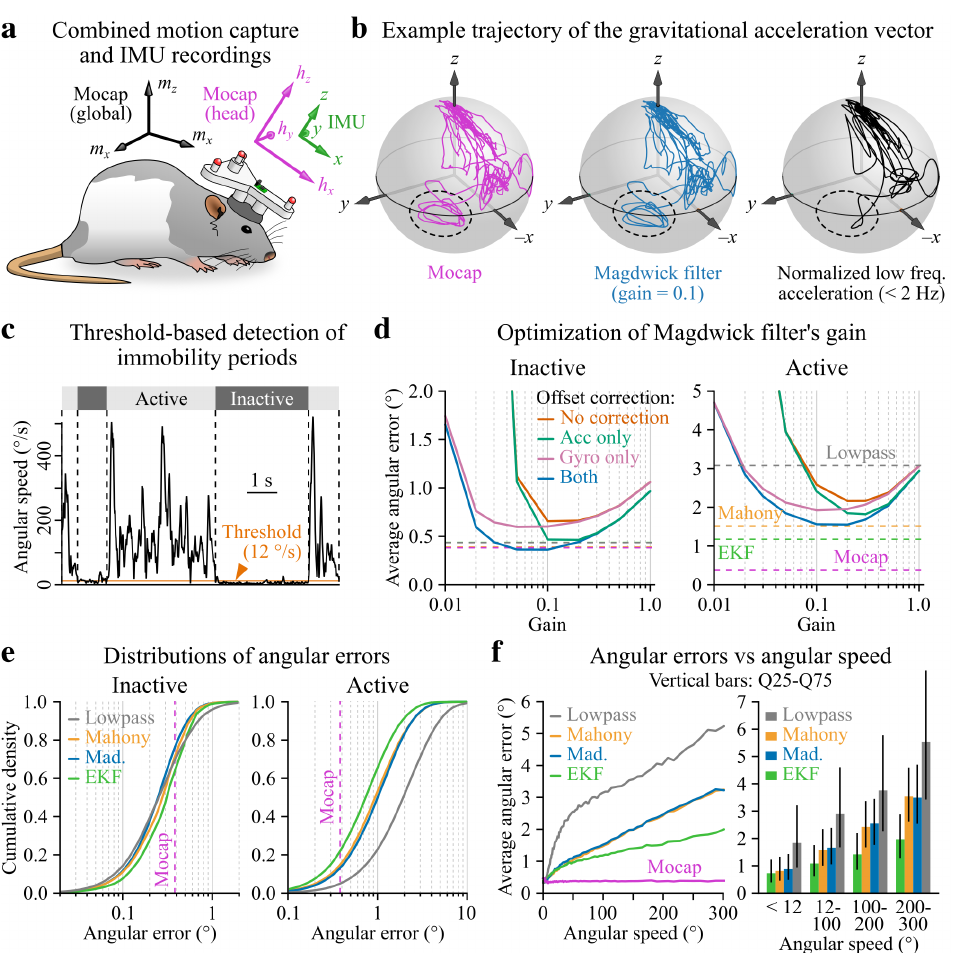
Figure 2. Calculation of the accuracy of IMU-based head tilt estimation using concurrent 3D optical motion capture in freely moving rats. ( a ) Animals were equipped with a head-mounted 3D-printed support containing four IR reflectors for motion capture (here shown in red) and a wired IMU (wire not represented). ( b ) Example trajectories of the actual gravitational acceleration vector (motion capture, left), of its estimate calculated with the Madgwick filter (middle) and of the normalized low frequency acceleration ( < 2Hz, right) over a period of 45s. The dashed ellipse highlights the region visited during a belly grooming episode. ( c ) Example angular speed trace (i.e., norm of the angular velocity vector) and corresponding periods of movement and immobility detected using a threshold of 12°s − 1 (orange line; see Section 2.9). ( d ) Average tilt estimation error for the Madgwick filter plotted against the filter’s gain, during immobility (inactive, left) vs. movement (active, right) and with or without offset correction. Dashed lines represent the average error calculated with the best set of parameters for other filters as well as the uncertainty in motion capture data (see Section 2.6.3). ( e ) Cumulative distribution of tilt estimation errors for all IMU filters during immobility (inactive, left) vs. movement (active, right). The vertical purple dashed line represents the uncertainty in optical motion capture data. ( f ) Tilt estimation error plotted as a function of the angular speed (left) and median error values and interquartile intervals calculated by bins of angular speed (right). Motion capture error was also plotted to confirm that the uncertainty in the optical estimation of tilt did not increase for specific ranges of angular speed (e.g., due to high intensity movements such as grooming occurring predominantly in conjunction with specific head orientations inducing marker